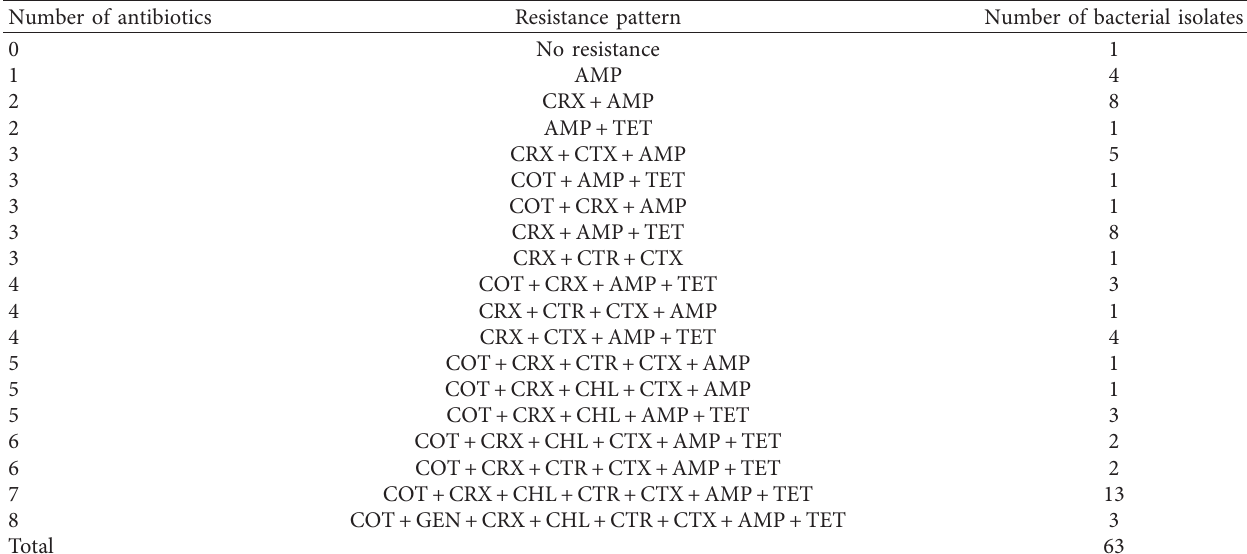
Table 3: Antibiotic resistance patterns observed among 63 coliform bacteria.